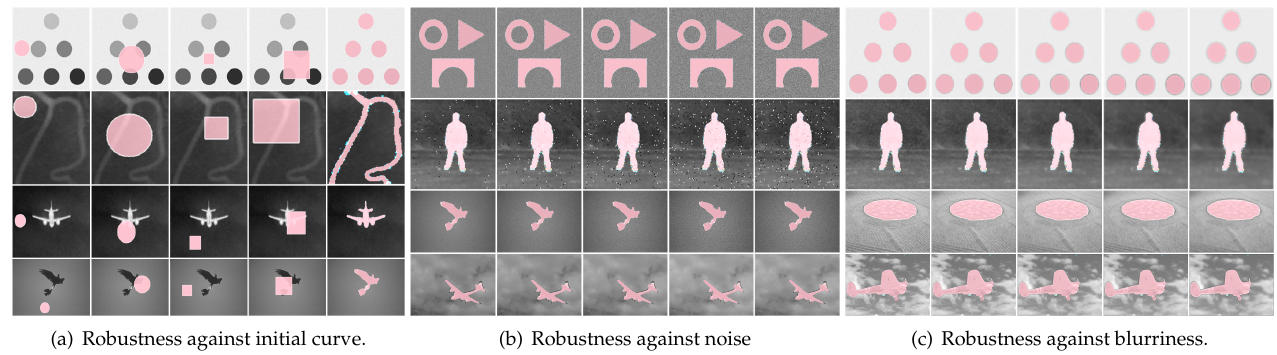
Figure 6. The verification of the robustness against initial curve, noise and blurriness of our method, respectively: ( a ) Columns 1–4 denote the original image with different initial regions, which are the enclosed by the initial curve, and Column 5 is the final segmentation; ( b ) the segmentation result on the images with different level noise; and ( c ) the segmentation results on the images with different